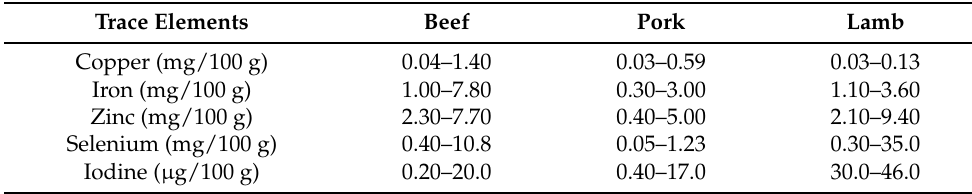
Table 2. Trace element nutrient composition range in red